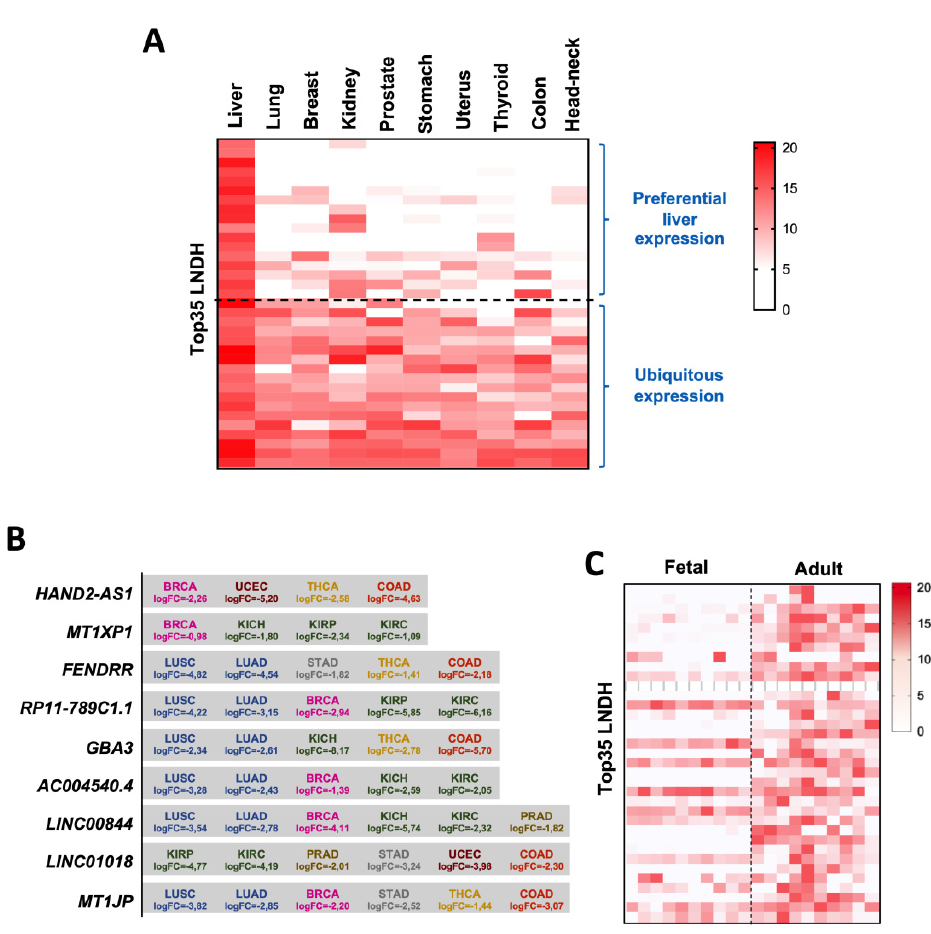
Figure 4. The Top35 LNDH can be divided into two subgroups according to their pattern of expres- sion: preferentially expressed in adult liver and ubiquitously expressed. ( A ) Heatmap reporting the expression levels of each of the Top35 LNDH in control tissues of different origins from TCGA datasets. Tissue represented: liver (n = 50), lung (LUAD n = 59; LUSC n = 49), breast (n = 113), kidney (KICH n = 24, KIRC n = 72, KIRP n = 32), prostate (n = 52), stomach (n = 32), uterus (n = 35), thyroid (n = 58), colon (n = 41) and head-neck (n = 44). The 35 lncRNAs are ranked according to the number of types of tissues where they are expressed, 17 of them being preferentially expressed in liver, whereas the other 18 showed a ubiquitous expression. The color scale bar is shown on the right representing relative expression. The corresponding ranked list is shown in Supplementary Figure S2A. ( B ) List of the 9 lncRNAs significantly downregulated in more than four tumor types besides HCC. The tumor type in which each lncRNA is significantly downregulated and the corresponding log2FC are indicated. ( C ) Heatmap reporting the expression levels of each lncRNA from the Top35 LNDH in fetal and adult liver from GSE111845 (n = 10) ranked as in Figure 4A. The color scale bar is shown on the right representing relative expression.